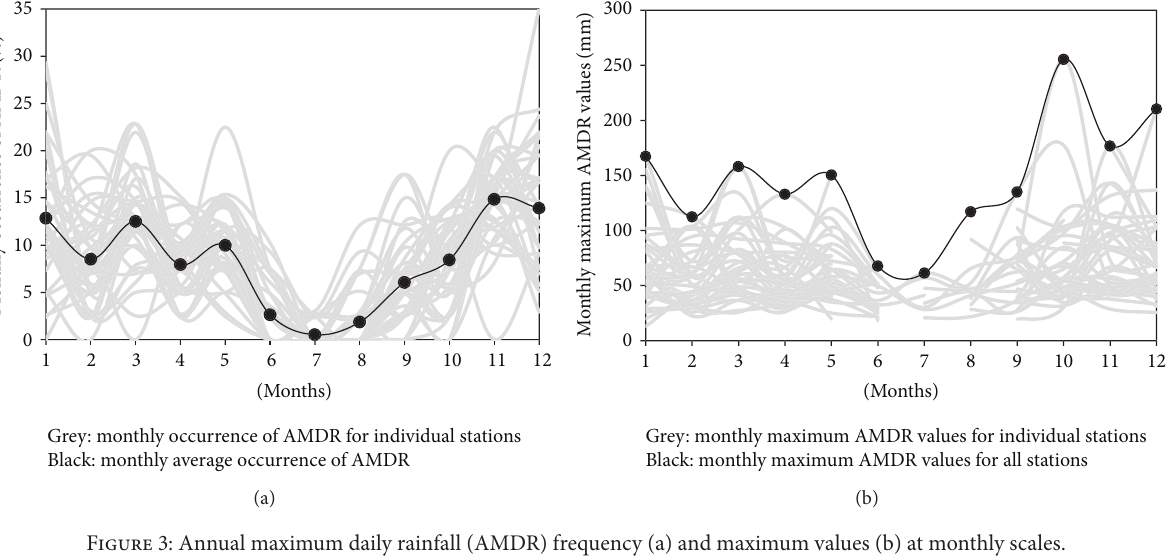
Figure 3: Annual maximum daily rainfall (AMDR) frequency (a) and maximum values (b) at monthly scales.